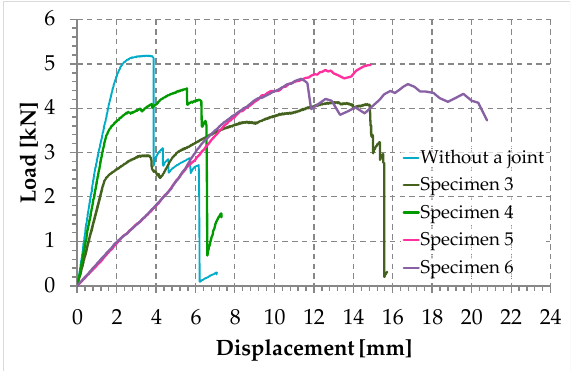
Figure 33. Load/displacement diagrams for 5 of the 7 specimens used for the mechanical characterization of the joints.